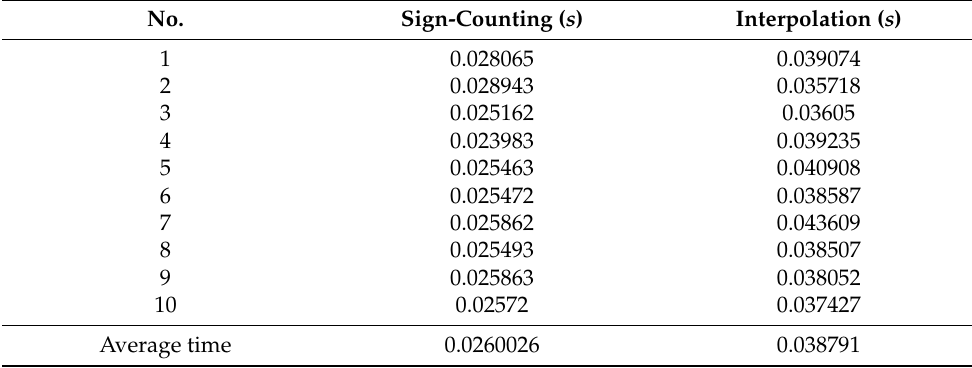
Table 2. Time comparison of sign counting and conventional method. No. Sign-Counting ( s